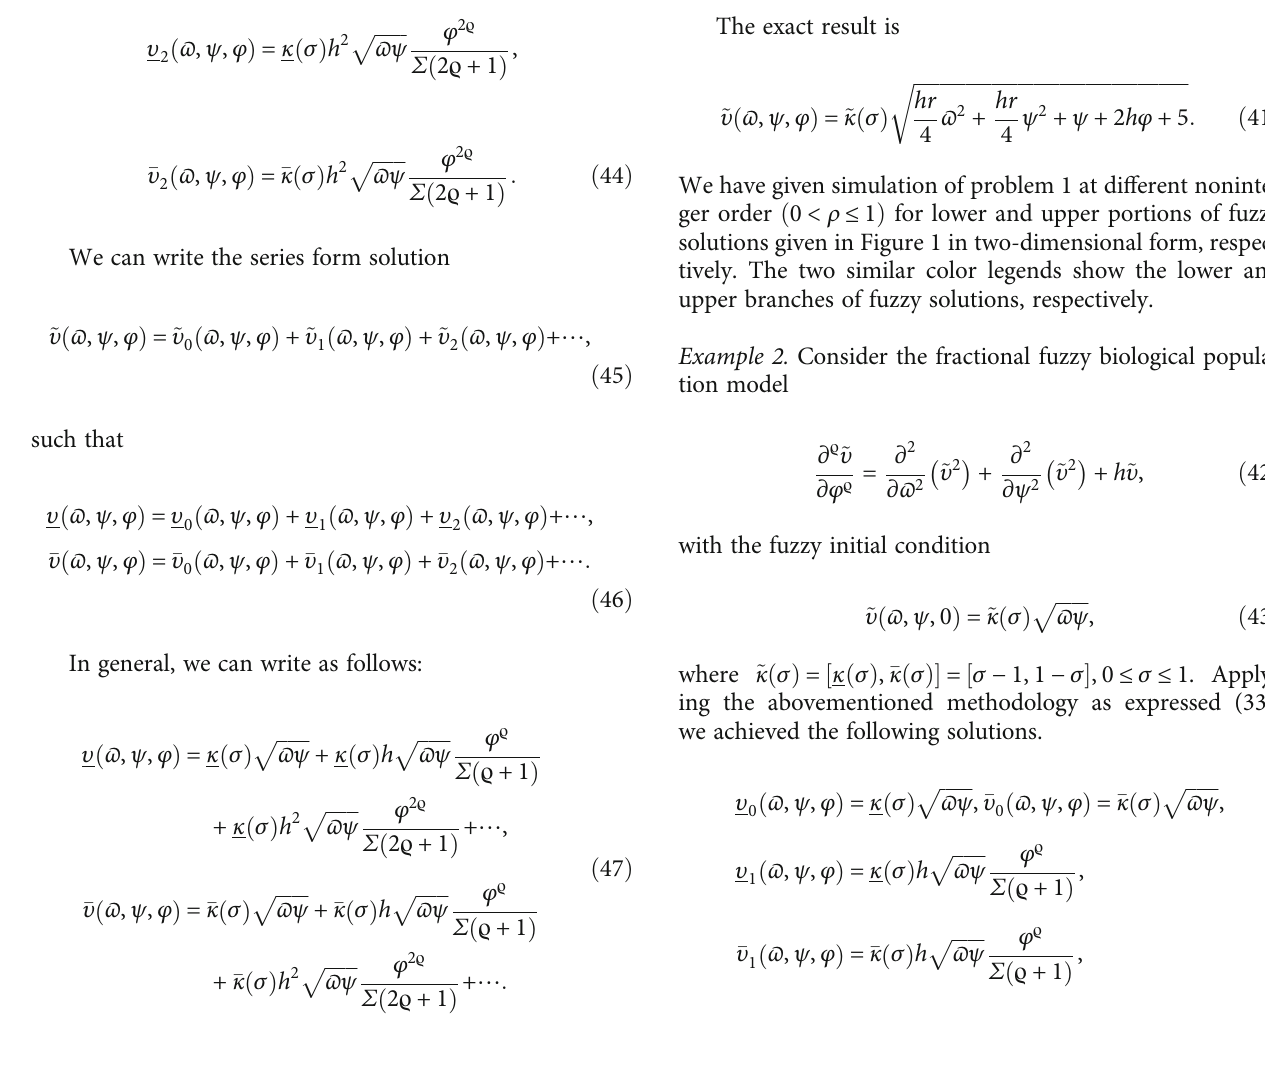
Figure 1: (a) A two-dimensional fuzzy upper and lower branch graph of an analytical series solution. (b) Di ff erent fractions of ρ . The exact result is